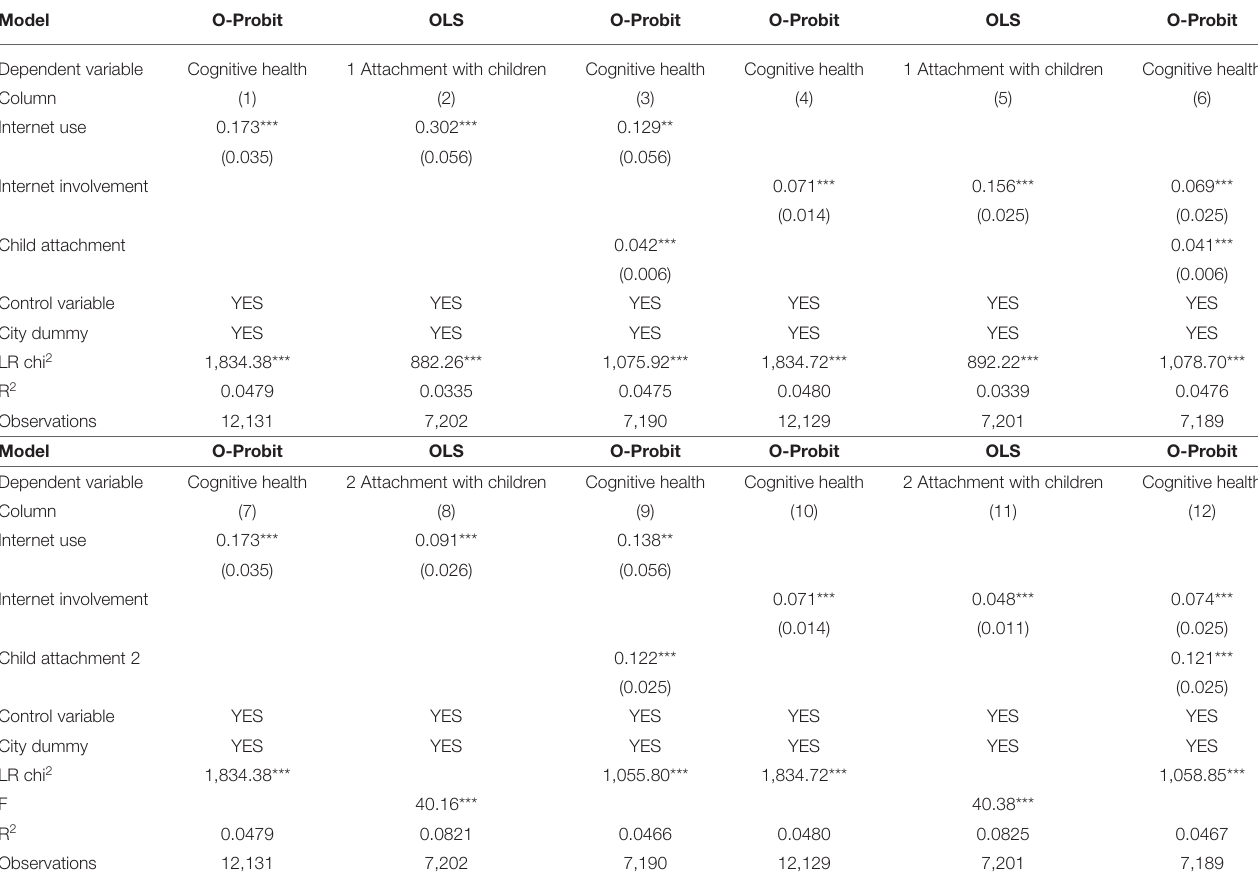
TABLE 5 | Causal stepwise regression results for the mediating